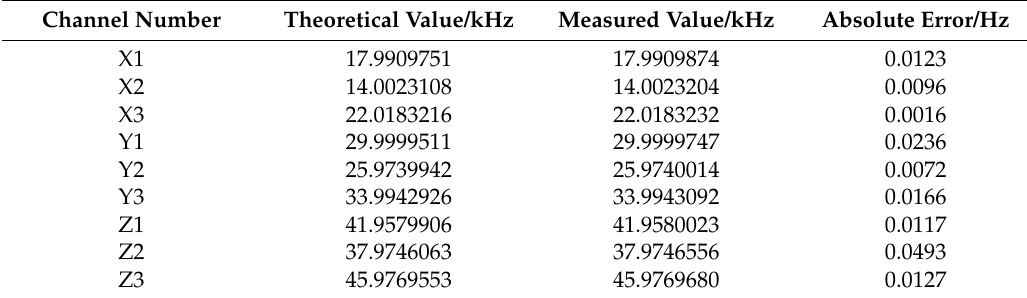
Table 1. Test results.